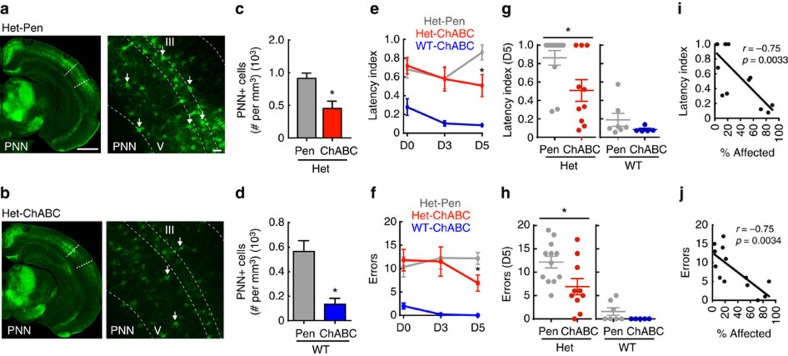
Pharmacological suppression of PNN formation in the auditory cortex restores wild-type behaviour in Mecp2het.(a,b) Samples of low (left panel) and high (right panel) magnification confocal images taken at D5, from the auditory cortex of SurHet that received injections of either a control enzyme (a, penicillinase) or an enzyme that dissolves PNNs (b, chondroitinase ABC). Arrows indicate high-intensity PNNs. Dashed lines delineate cortical layers with layers III and V indicated. Scale bars in a: left image=1 mm, right=50 μm, which also apply to the respective images in b. (c,d) At D5, chondroitinase ABC (ChABC) significantly dissolved PNNs in the injected brains of Het (c) and WT (d) compared with their respective penicillinase (Pen) -injected genotypes (Het-Pen: n=710 PNN+ cells, 31 images, 8 mice; Het-ChABC: n=273 PNN+ cells, 24 images, 6 mice; Mann Whitney, *P=0.0003; WT-Pen: n=455 PNN+ cells, 32 images, 8 mice; WT-ChABC: n=108 PNN+ cells, 32 images, 8 mice; Mann Whitney: *P<0.0001). Bar graphs represent mean±s.e.m. (e–h) Pup retrieval behaviour improved significantly on D5 in SurHet injected with ChABC (orange), as measured by normalized latency (e,g) and errors (f,h) compared with penicillinase-injected SurHet (grey) (Het-Pen: N=12 mice; Het-ChABC: N=10 mice; ANOVA: Tukey's post-hoc test, *P<0.05). No significant differences in latency and errors were observed between ChABC-injected and penicillinase-injected WT except at D3 (Mann–Whitney, P=0.048). For simpler graphic presentation, only ChABC-injected WT data are shown in blue (WT-Pen: N=7 mice; WT-ChABC: N=5 mice). Mean±s.e.m. are shown. (i,j) Correlation analysis showed a significant negative relationship between the proportion of auditory cortex encompassed by chondroitinase ABC injection for both latency (i) and number of errors (j) at Day 5 (N=13 mice; Pearson's r: For I: r=−0.75, P=0.0033; for J: r=−0.75, P=0.0034).